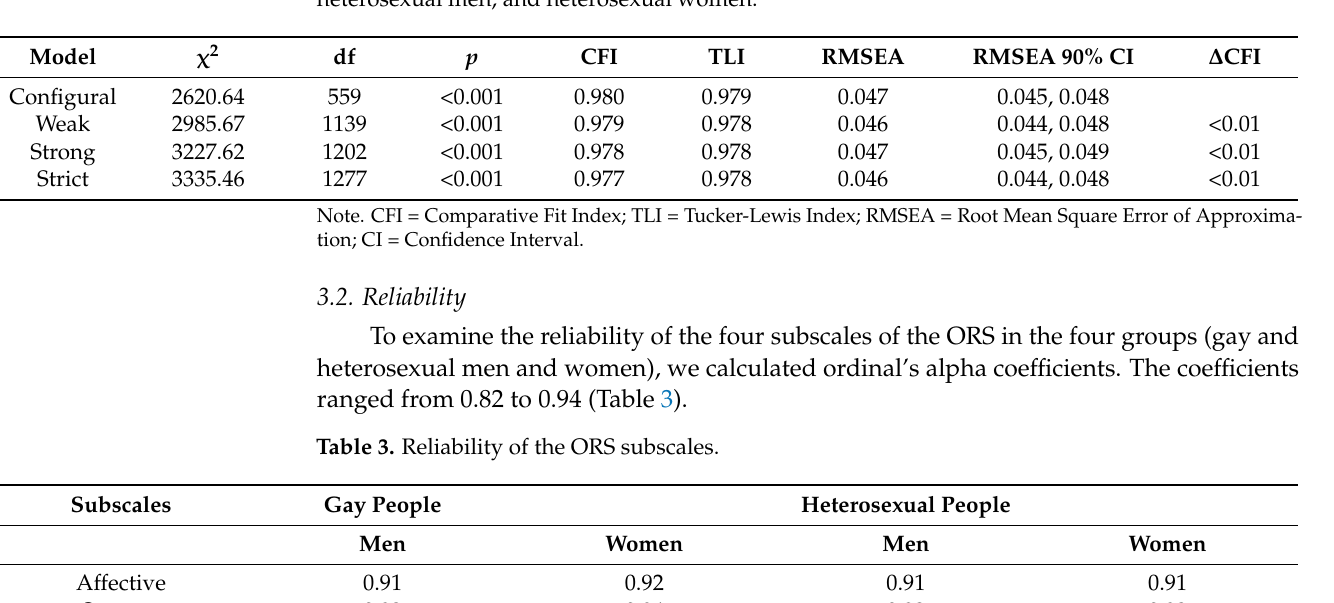
Table 2. Factorial invariance according to sex and sexual orientation: gay men, lesbian women, heterosexual men, and heterosexual women.